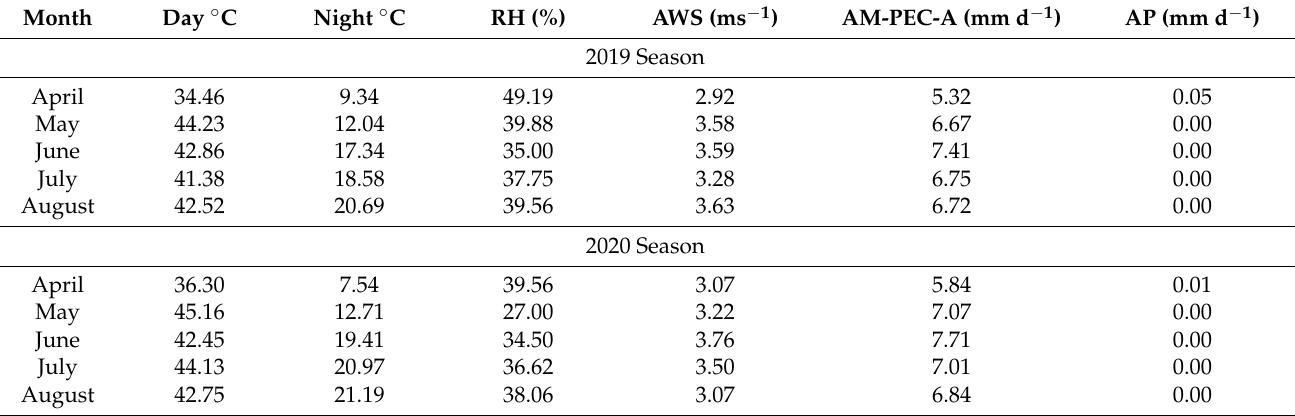
Table 1. Weather data for the study region in Egypt over the sweet potato growing seasons.